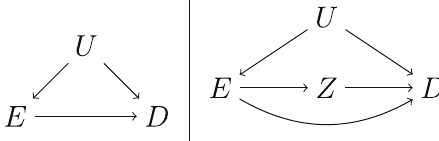
Figure 1: Causal graph where U is